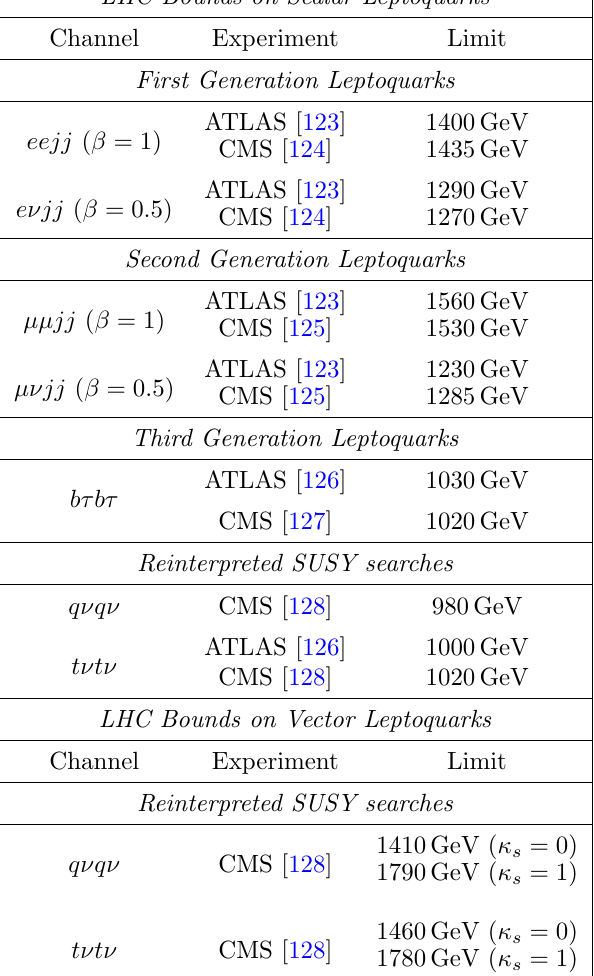
Table 2 . LHC bounds on pair-production of scalar and vector leptoquarks. For scalar leptoquarks, the (cid:12)rst three sections correspond to bounds from dedicated leptoquark searches, while the last section corresponds to bounds derived from the reinterpretation of squark pair production searches. For vector leptoquarks, only reintepreted SUSY searches exist. The parameter (cid:12) denotes the branching ratio of the leptoquark to a quark and a charged lepton. We do not report the bounds on the decays of the LQ to down-type quarks and a neutrino since these decays do not exist in our